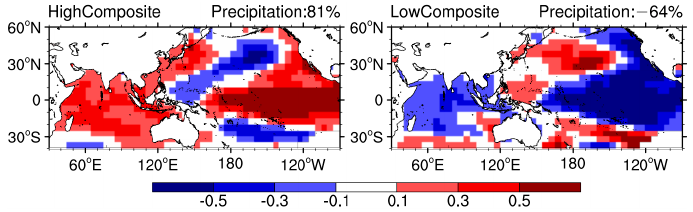
Figure 2. The composites of the prophase winter SST anomalies in high and low precipitation years (precipitation over the MLYR). The corresponding high and low precipitation anomaly percentages are shown at the top right corner.